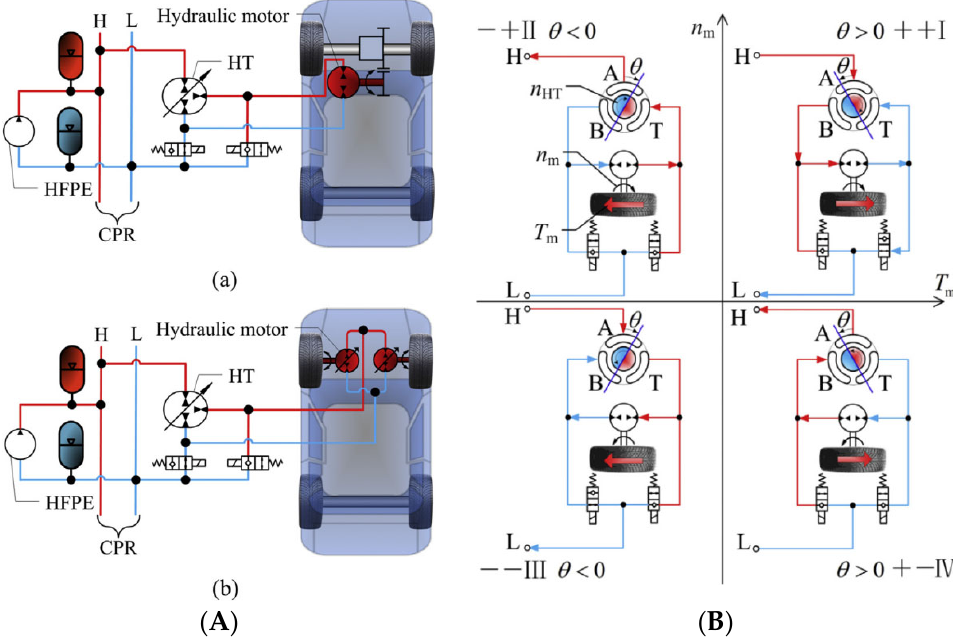
Figure 8. Configuration and principle of the hydraulic vehicle [75]: ( A ) structure of the proposed hydraulic hybrid propulsion system: ( a ) passive type; ( b ) active type; ( B ) working principle.